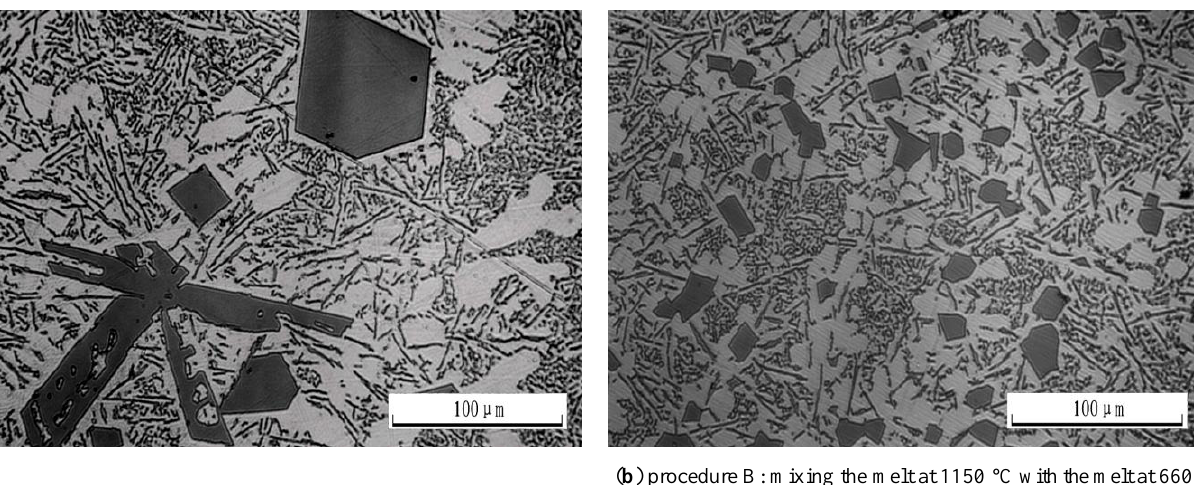
Figure 20. Solidified structures of the Al-Si20 (wt%) alloy from different liquid